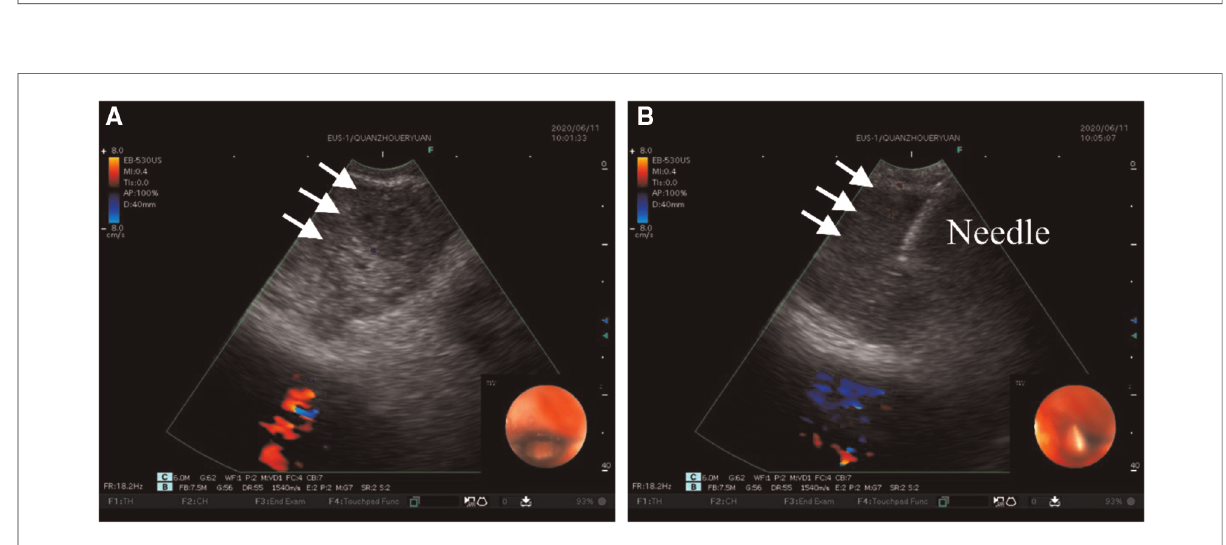
FIGURE 3 Ultrasound images of EBUS-TBNA. ( A ) Convex-probe ultrasound demonstrates the hypoechoic lesion (arrows), while the endoscopic Doppler image re fl ects the blood fl ow within the right atrium. ( B ) EBUS-TBNA was performed using a 22-gauge